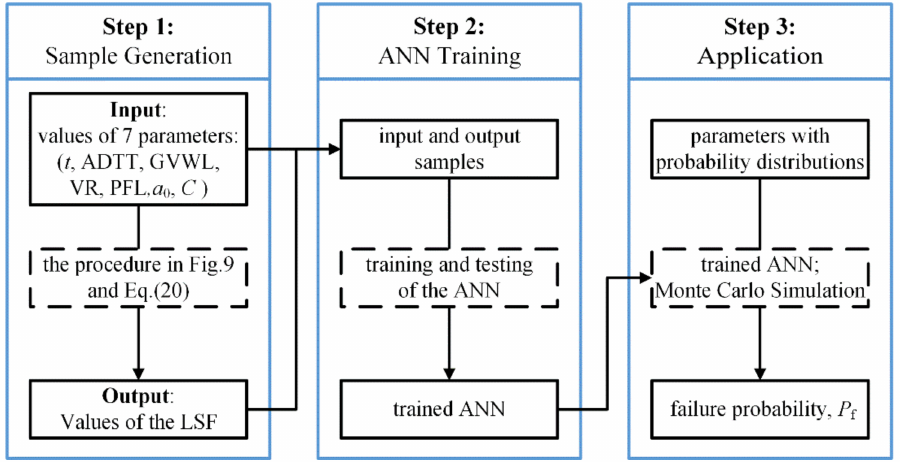
Figure 9. Procedure of the ANN-MCS method for reliability